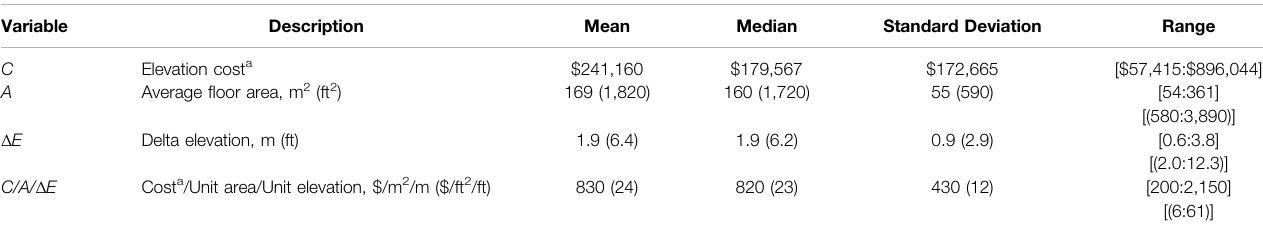
TABLE 2 | Statistical mean, median, standard deviation and range for 139 observations.